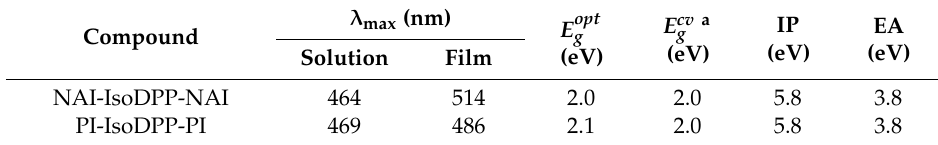
Table 1. Optical and electrochemical data for NAI-IsoDPP-NAI and PI-IsoDPP-PI. Compound